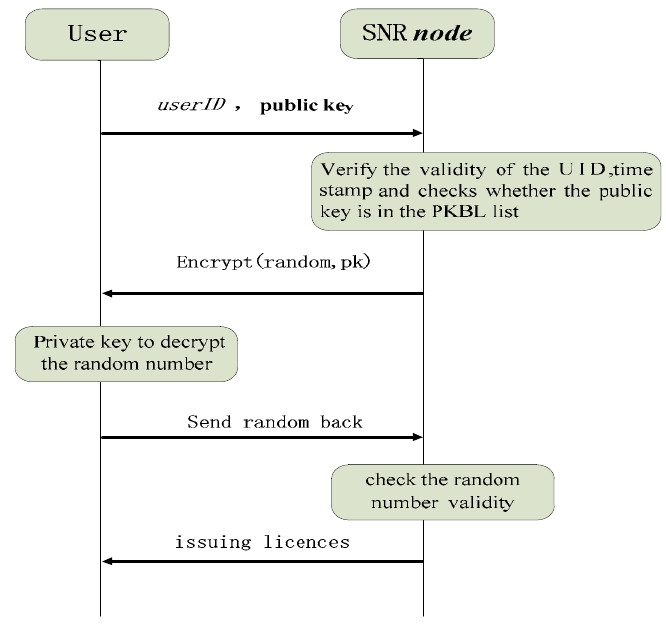
Figure 2. Name registration